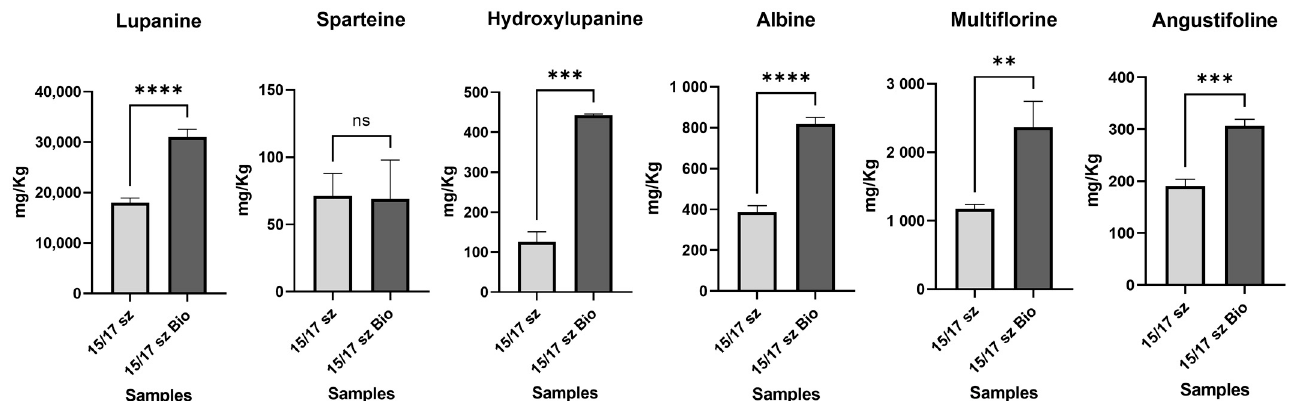
Figure 7. In this histogram plots, all 6 LAs detected in the conventional farming raw lupin samples and organic farming raw lupin samples were reported. The samples were grouped for each LA. The concentration of the LAs is reported as mg Kg − 1 of sample. Y axis title = Concentration (mg Kg − 1 ). X axis Title = Different farming conditions. (**) = p -value ≤ 0.01, (***) = p -value ≤ 0.005, (****) = p -value ≤ 0.001.